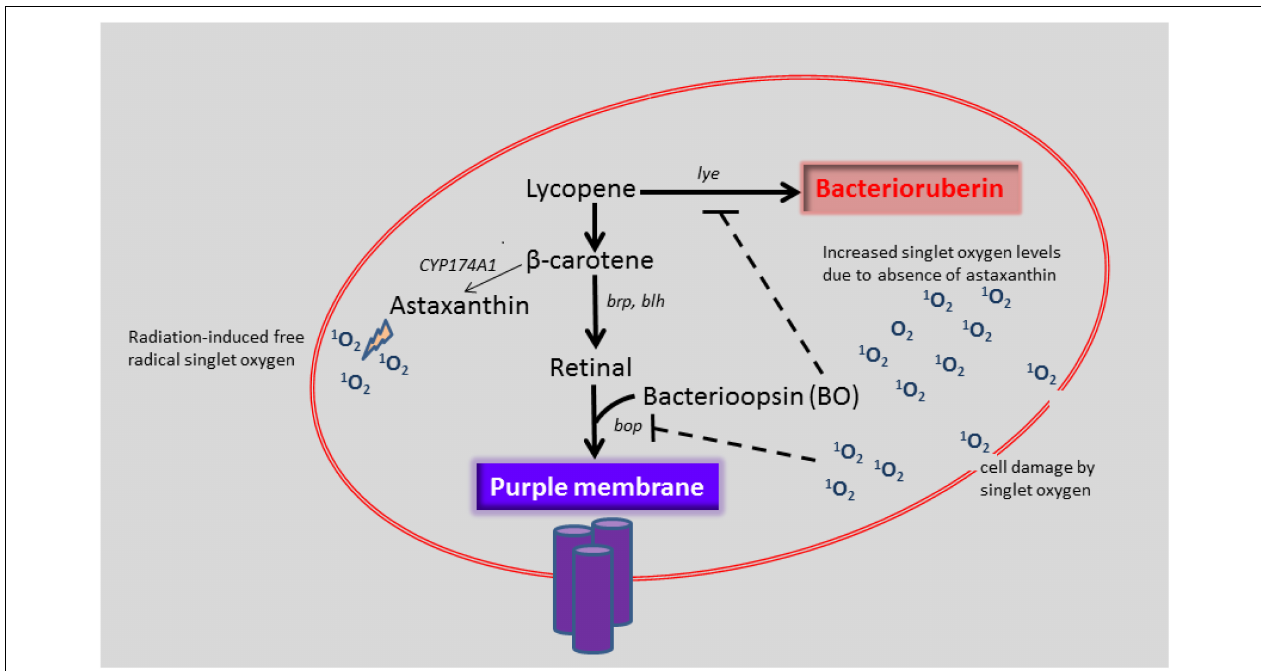
FIGURE 3 | Proposed function of CYP174A1 in astaxanthin biosynthesis and the effect of increased singlet oxygen levels on bop expression in H. salinarum . The role of CYP174A1 in astaxanthin biosynthesis in H. salinarum has to be verified.